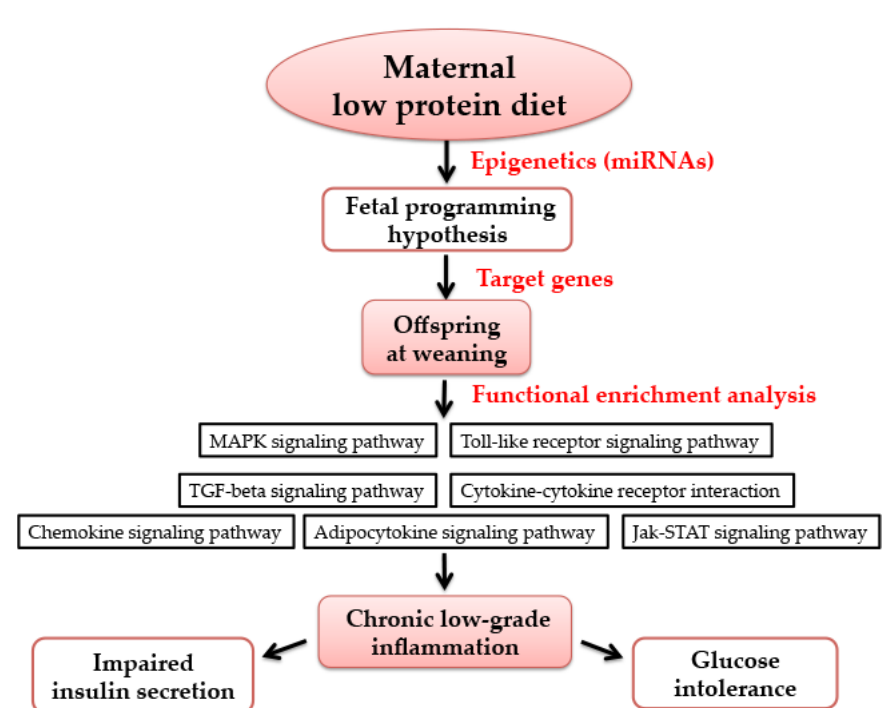
Figure 7. The possible mechanism of maternal low ‐ protein diet during pregnancy and lactation on offspring at weaning. Maternal nutrition has long ‐ term metabolic effects on offspring, which is known as the “fetal programming hypothesis”. Epigenetics (such as miRNAs) has been deemed as an important molecular basis of maternal nutrition and metabolic health in offspring. Using functional enrichment analysis, the target genes of differentially ‐ expressed miRNAs were mapped into seven pathways, which are all associated with inflammation. Thus, it may be related to chronic low ‐ grade inflammation, which may cause impaired insulin secretion and glucose intolerance. MAPK: mitogen ‐ activated protein kinase; TGF: transforming growth factor; Jak ‐ STAT: Janus kinase ‐ signal transducer and activator of transcription.